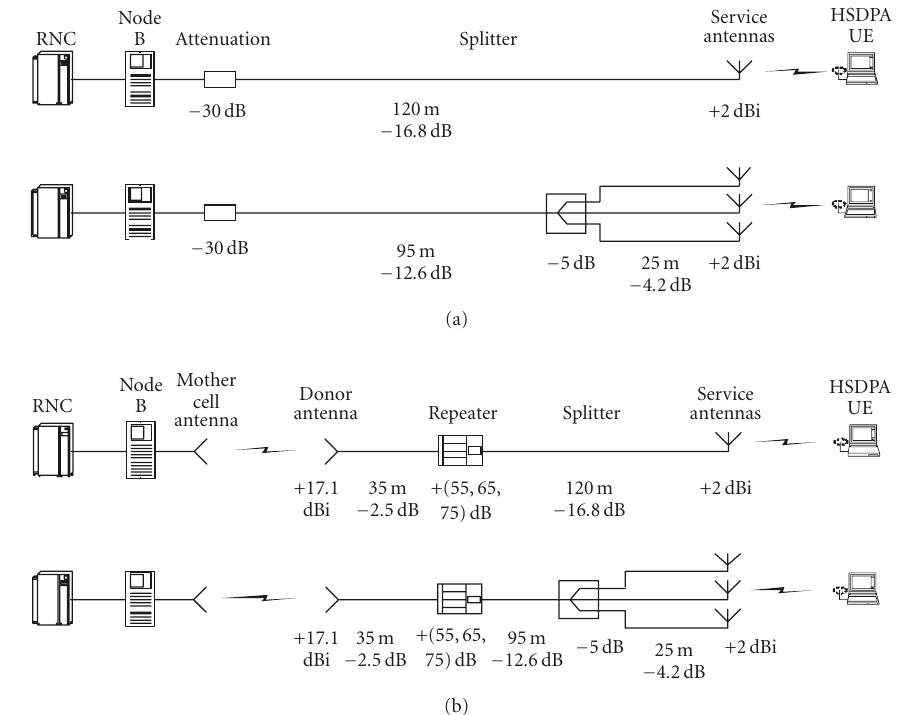
Figure 4: System block diagrams and antenna configurations for (a) dedicated indoor system measurements and (b) outdoor-to-indoor repeater measurements, both with 1 and 3 antenna DASs.